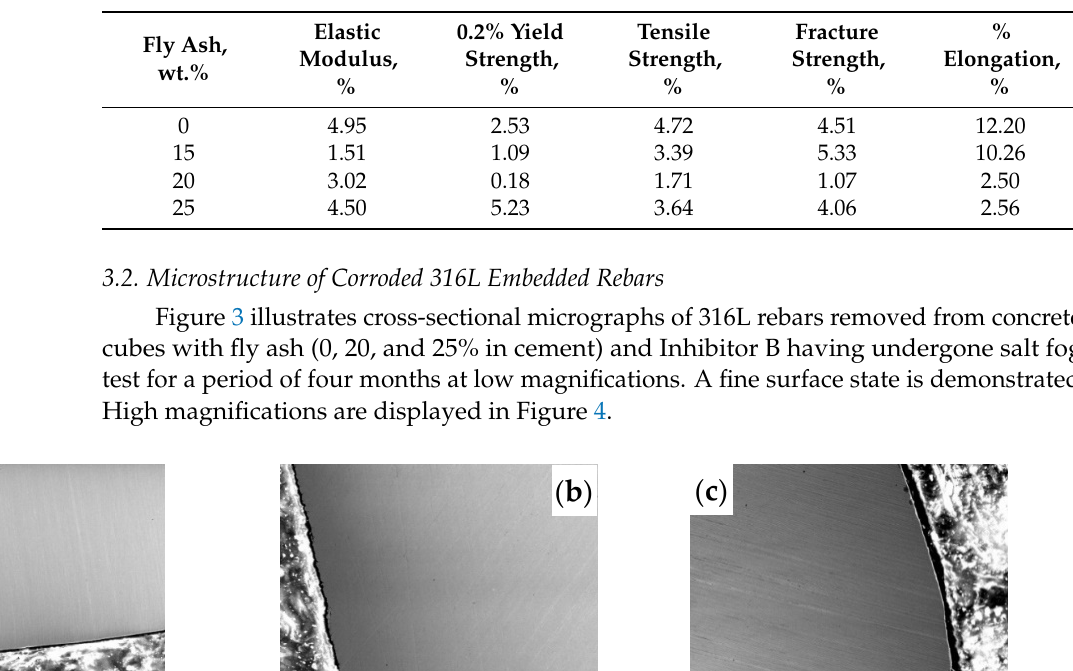
Table 2 presents the reduction percentage (%) of mechanical property values after the salt fog test for concrete cubes embedded with 316L rebars and mixed with FA and FA + Inhibitor B. In general, FA addition led to smaller losses of mechanical properties com- pared to concrete cubes free of FA. A total of 20% FA addition led to the lowest losses in the mechanical properties (with the exception of the elastic modulus) in agreement with previous efforts that showed that 20% FA addition leads to the highest corrosion re- sistance for 316L and 304L rebars in electrolytes simulating concrete pores exposed to var- ious harsh environments [13–16]. A total of 25% FA addition led to higher property losses compared to 20% FA, with analogy to electrochemical behavior tests [13–16]. Table 2. Decrease percentage (%) of mechanical property values of 316L bars reinforcing concrete that contains fly ash (0, 15, 20, 25% of cement) in combination with Inhibitor B after salt fog spray testing.